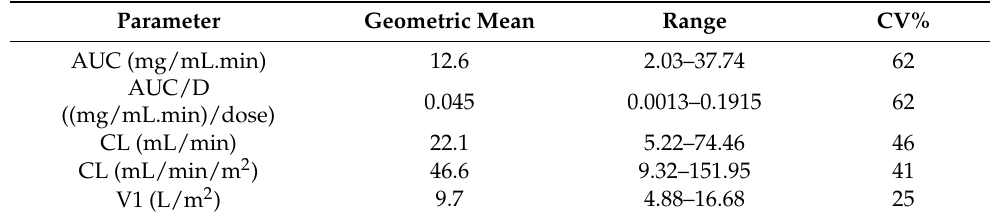
Figure 2. The effect of ( A ) age, ( B ) weight and ( C ) CYP2B6 genotype on cyclophosphamide clearance. The error bars represent standard deviation, the dashed line indicates the mean cyclophosphamide clearance of 52.8 mL/min/m 2 . Table 2. Summary of average cyclophosphamide pharmacokinetic parameters generated for the infants on the